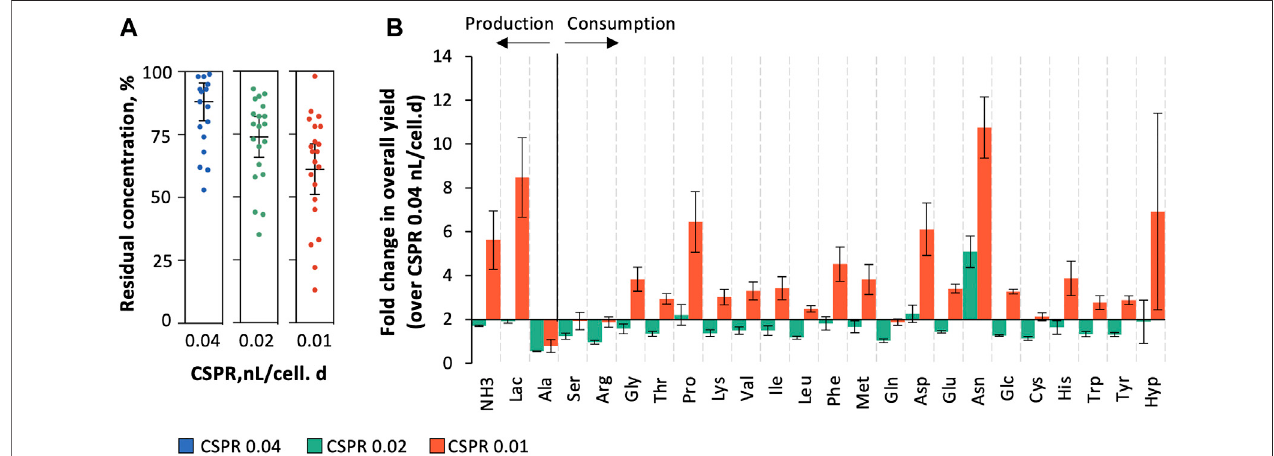
FIGURE 4 | Targeted metabolite pro fi ling assessed by HPLC. (A) Residual concentration of amino acids (percent of medium concentration); (B) overall yield coef fi cients for substrate j consumed ( Y X , S ) or product j formed ( Y X , P ) per biomass (fold change over CSPR of 0.04 nL/cell.day). j j